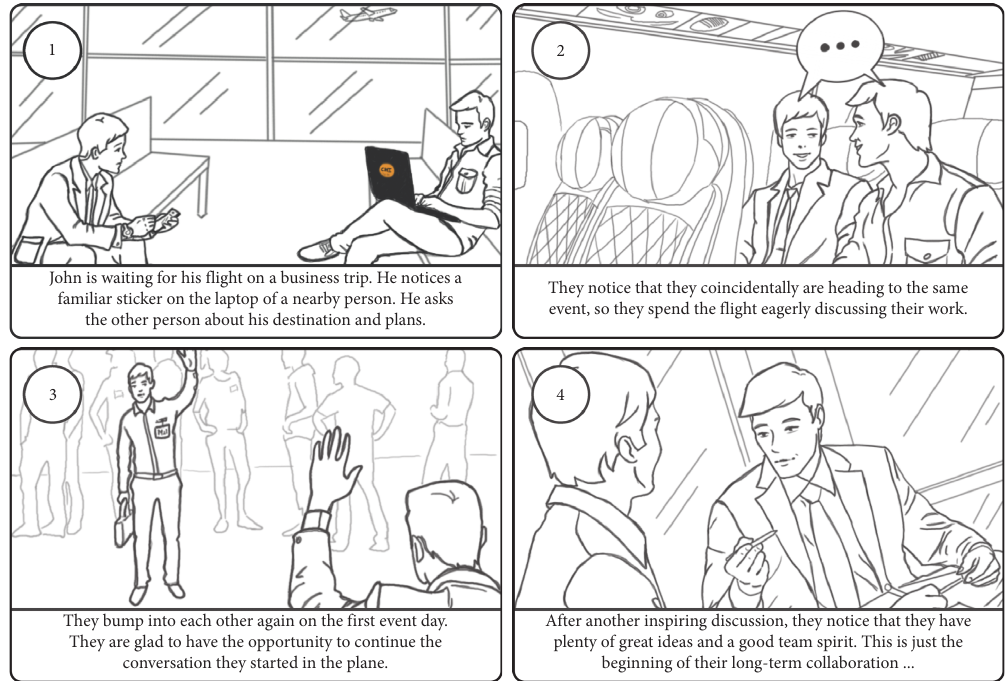
Figure 1: Fictional example of an unexpected encounter that turns into social